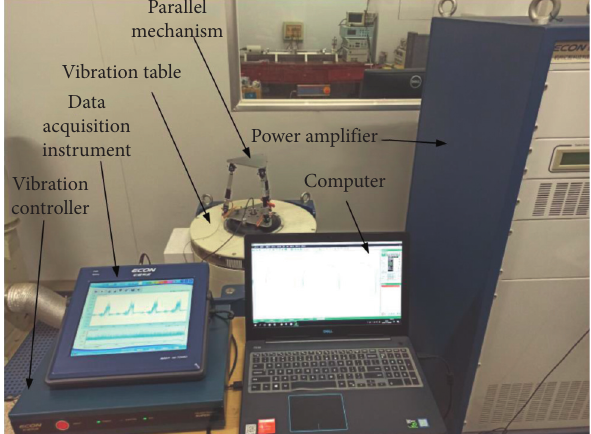
Figure 20: The experiment of the vibration isolator.